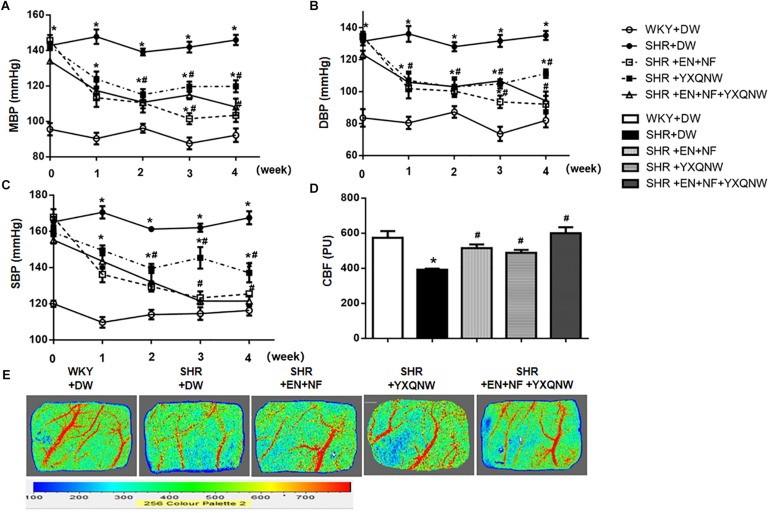
YXQNW attenuates the blood pressure and cerebral blood flow decrease in SHR. Panels (A–C) show the change of MBP, DBP, and SBP with time, respectively, before (0 week) and after (1, 2, 3, and 4 week) drug administration in each group. n = 30. (D) Quantitative analysis of CBF in different groups. The unit of Y-axis is perfusion unit (PU). (E) The representative images of CBF of ipsilateral cortex in different groups. The magnitude of CBF is represented by different colors, with blue to red denoting low to high. Values are the mean ± SEM. ∗P < 0.05 vs. control group, #P < 0.05 vs. SHR + DW group.